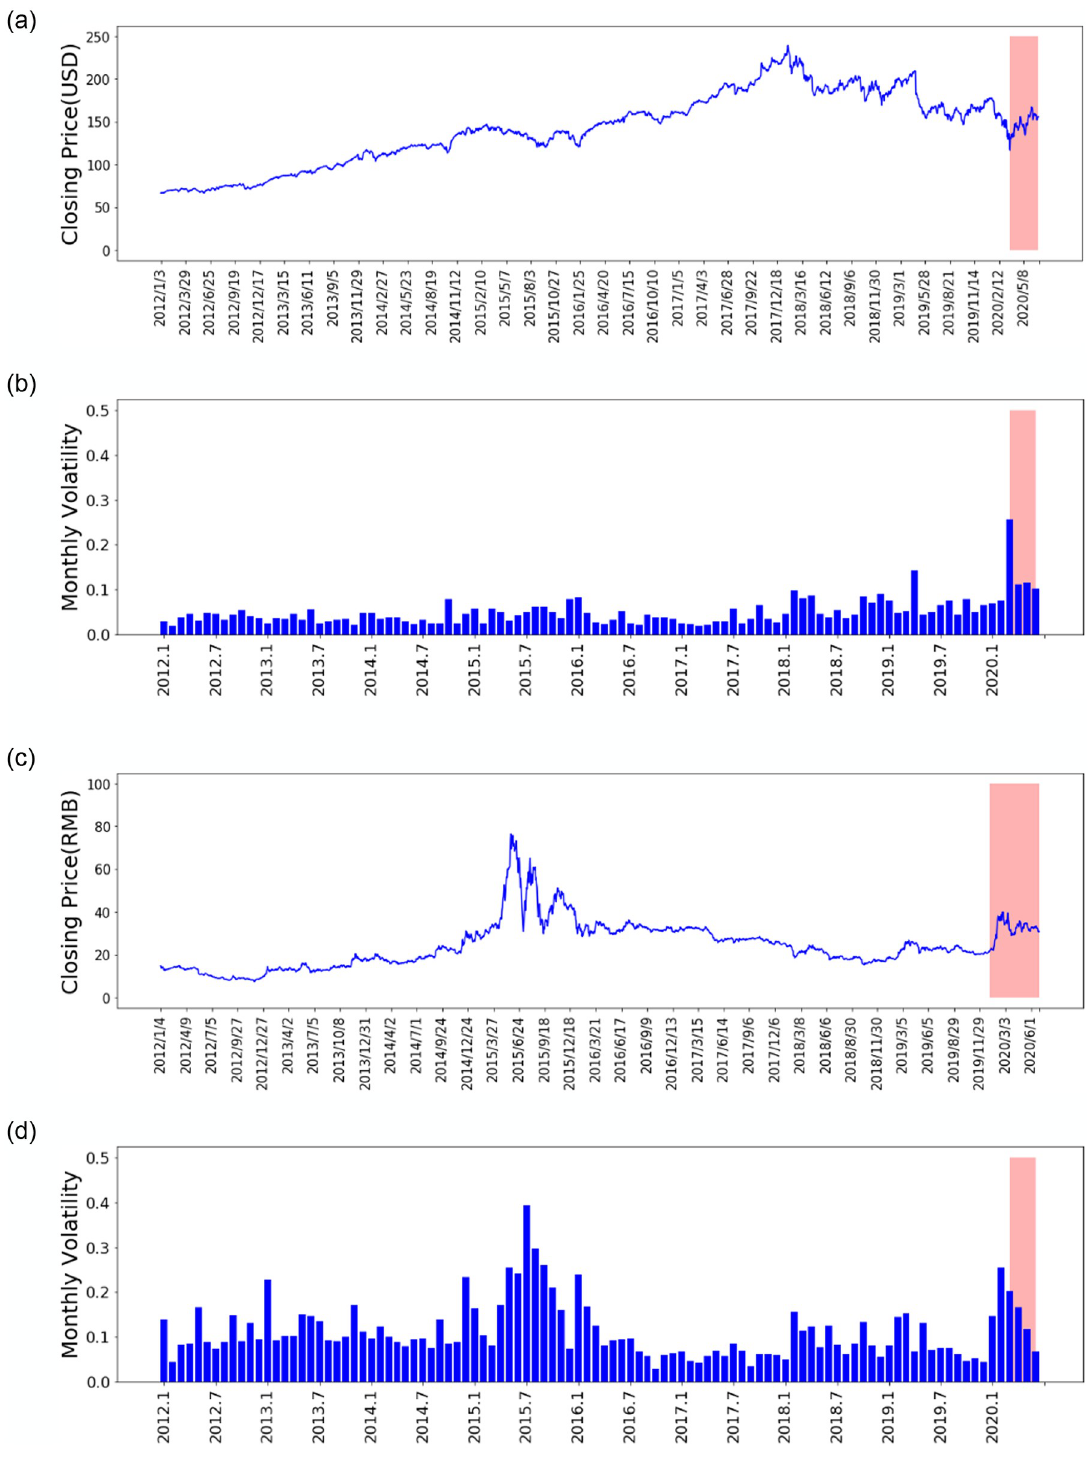
Fig 14. Stock price time series and monthly volatility for stocks MMM and 600118.SS.